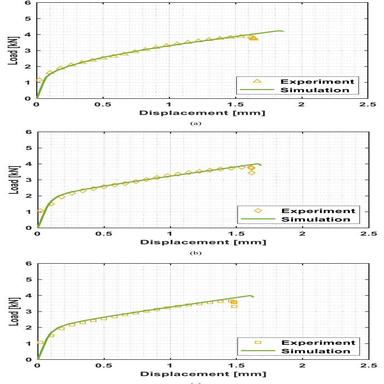
Load-displacement curve in the compression test of the specimen with (a) no pre-tensile strain, (b) pre-tensile strain of 0.079, and (c) pretensile strain of 0.093.